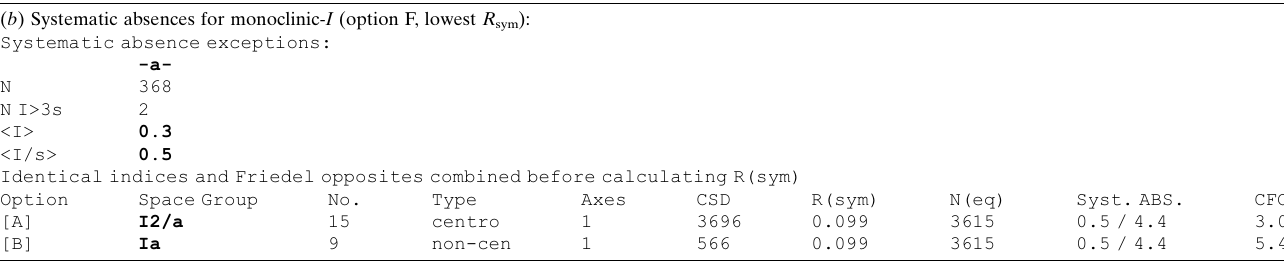
Two 90 (cid:3) steps generate a twofold rotation (as for a pseudo- orthorhombic twin), while the fourth step regenerates the starting position. The presence of pseudo-tetragonal twinning would result in significant populations for four individuals, as opposed to two if it were a pseudo-orthorhombic twin.